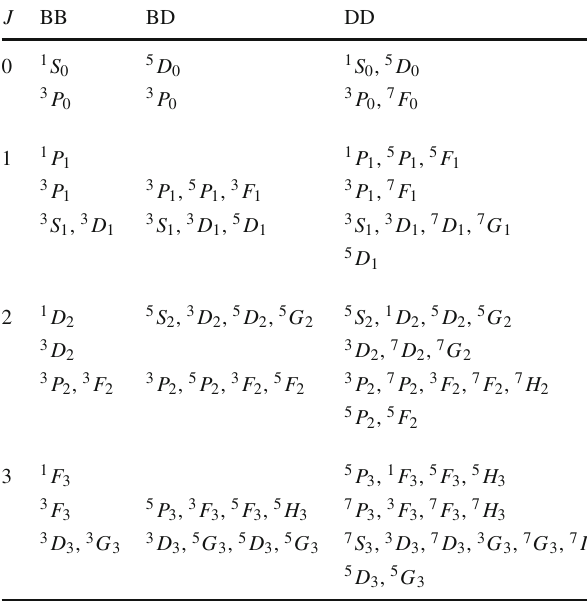
Table 2 Partial waves for BB, BD, and DD scattering for angular momenta J ≤ 3 J